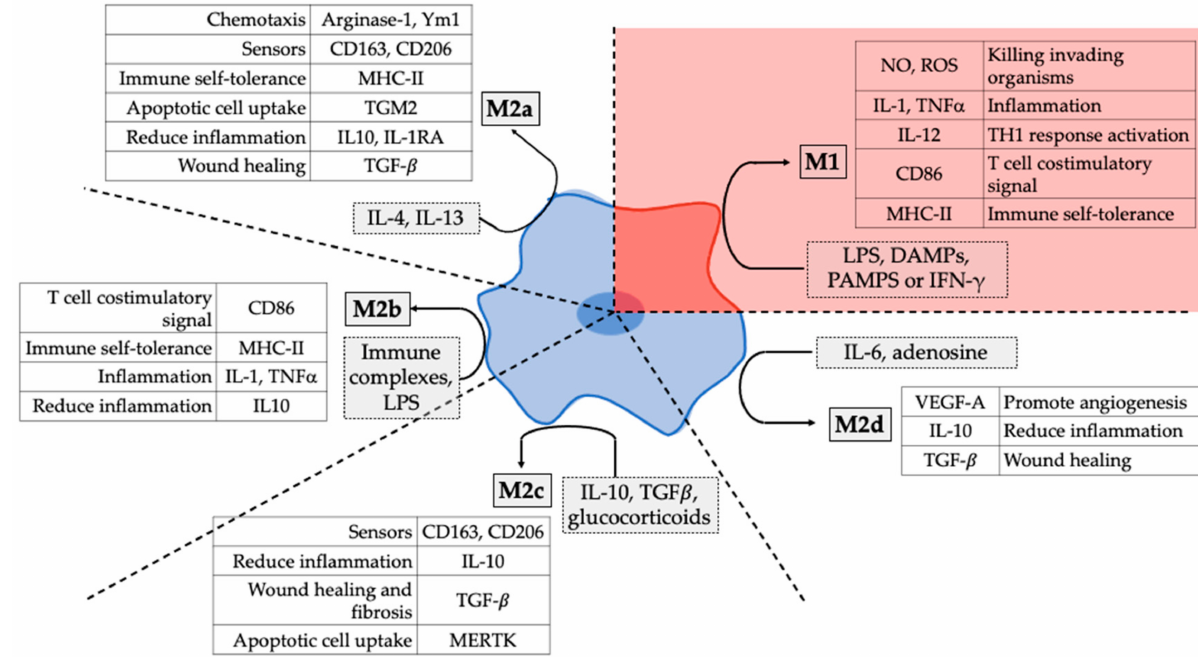
Figure 1. Overview of macrophage phenotypes. The figure shows the phenotypical division of macrophages in M1 and M2 phenotype and the subcategories of M2 macrophages (M2a, M2b, M2c, M2c). It also shows the markers expressed by the different macrophage phenotypes upon activation by different stimuli and their functions. CD: Cluster of differentiation; LPS: lipopolysaccharide; MHC-II: Major histocompatibility complex—II; TGM2: Transglutaminase 2 (TGM2); IL: Interleukin; IL-1RA: interleukin 1 receptor antagonist; TGF- β : tumor growth factor beta; TNF α : tumor necrosis factor alpha; ECM: extracellular matrix; MERTK: MER Proto-Oncogene Tyrosine Kinase; NOS: Nitrogen oxide species; ROS: Reactive oxygen species; DAMP: damage-associated molecular patterns; PAMP: pathogen molecular patterns; IFN- γ : Interferon gamma; VEGF-A: Vascular endothelial growth